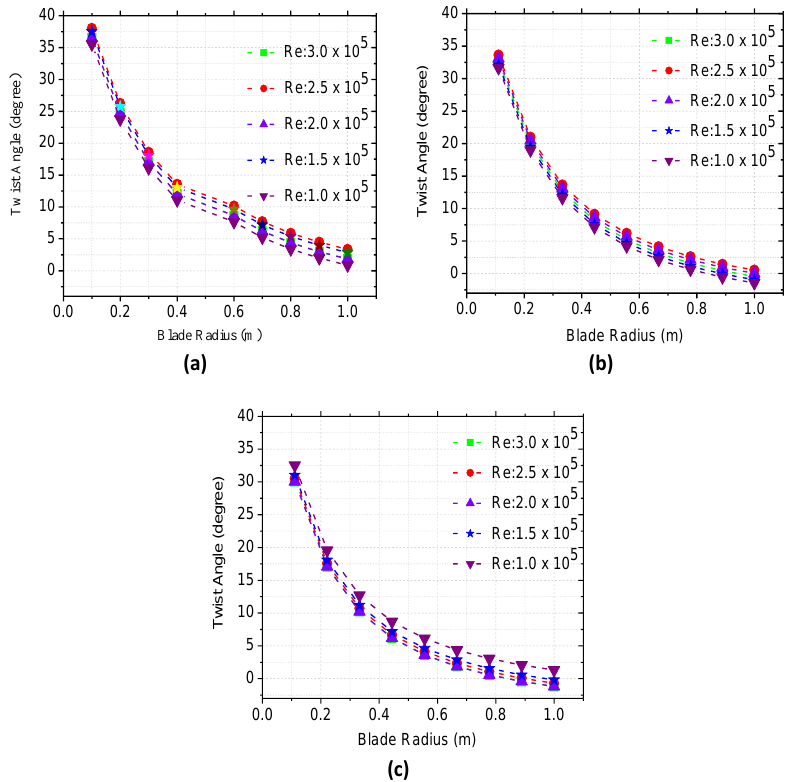
Figure 7. Blade optimum twist distributions for NACA 4412 airfoil at ( a ) TSR 4; ( b ) TSR 5; ( c ) TSR 6.